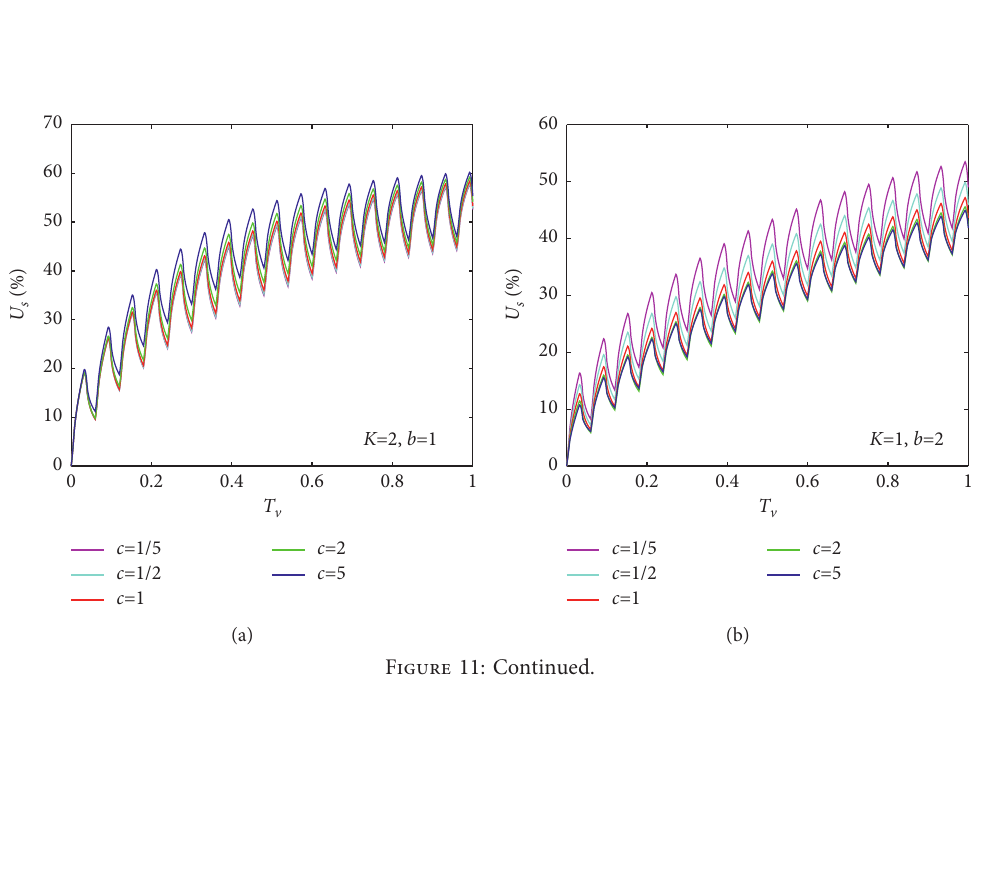
Figure 10: The excess pore pressure isochrones under different values of c .